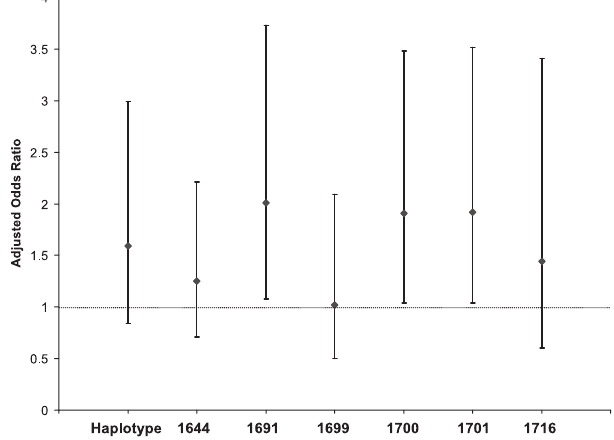
Figure 7. Association between Change in Predominant Haplotype or Amino Acid and Development of Clinical Symptoms ORs comparing the odds of a change in predominant haplotype or amino acid during intervals between two consecutive infections during which clinical symptoms developed, to the odds of a change during intervals between consecutive infections during which no symptoms developed, adjusting for year, age, and time between infections. Diamonds indicate point estimates and bars indicate 95% CIs. The dashed line designates an OR of 1, or no effect.